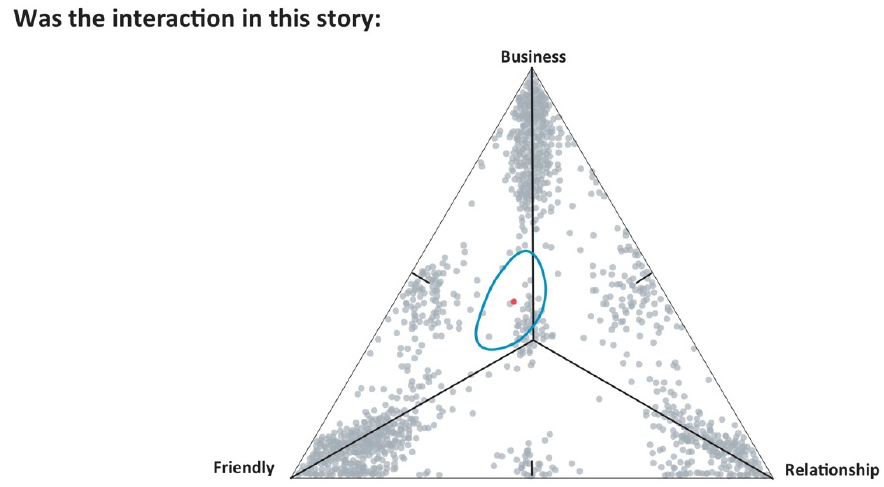
Figure 5. Aggregated geometric mean for Triad 3: Was the interaction in the story: (i) friendly, (ii) business, or (iii) a relationship.